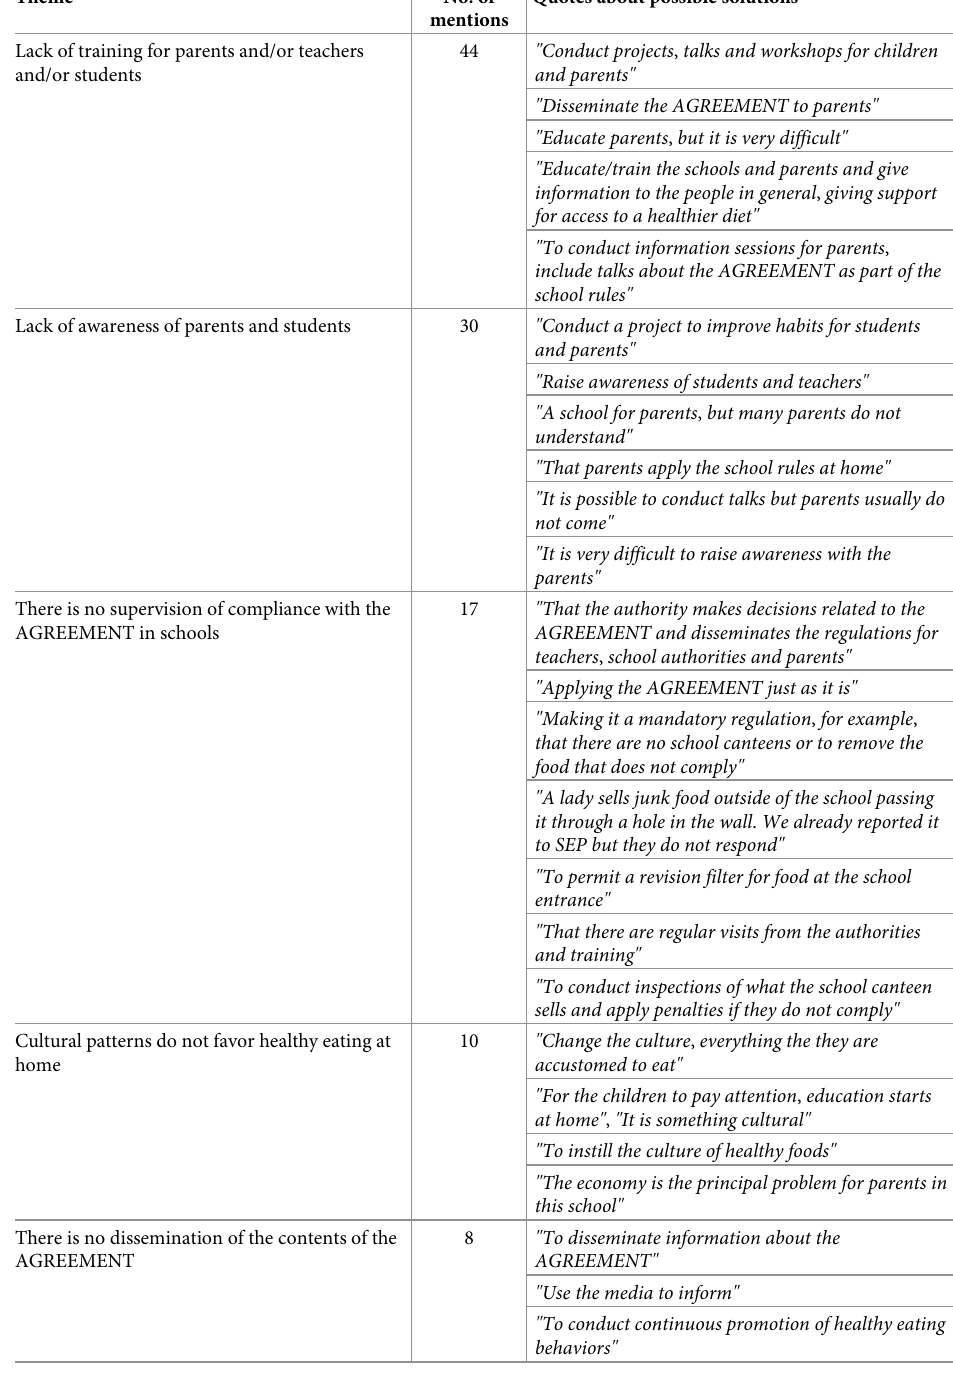
Table 3. Perception of the barriers and potential solutions mentioned by the school authorities during the inter- view (n =